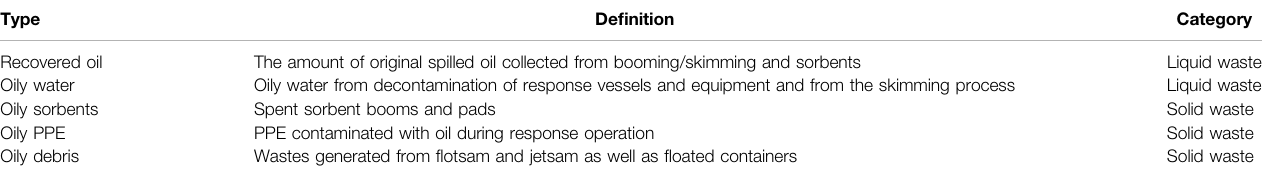
TABLE 1 | Types of oily waste considered in the system dynamics model.